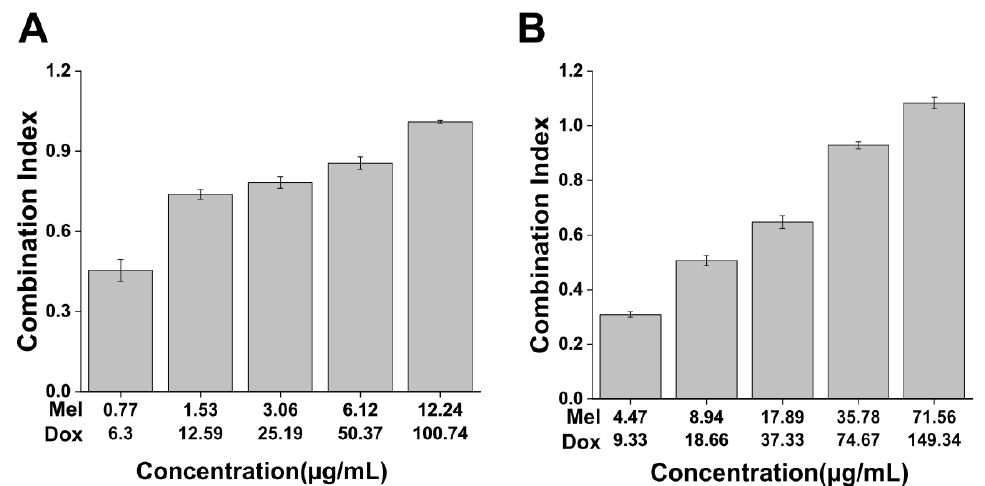
Table 1. IC 50 of melittin and doxorubicin in MCF-7 or MCF-7/ADR cells.